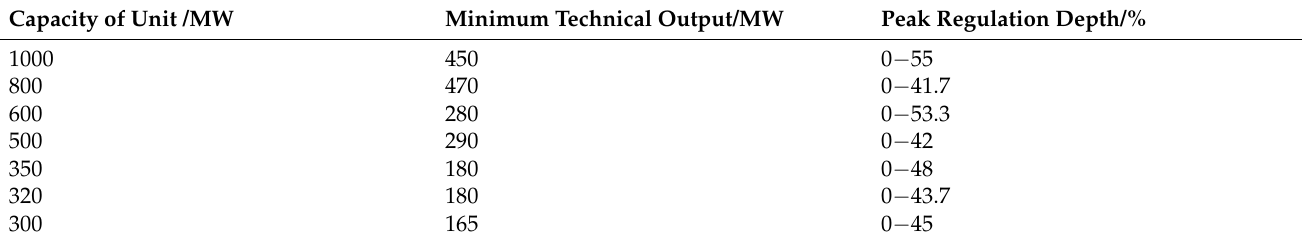
Table A3. Investigation results of peak regulation depth of different coal − fired units typed by capacity. Capacity of Unit